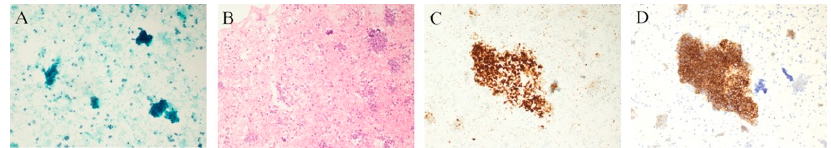
Figure 6. A case of small cell neuroendocrine carcinoma was categorized as malignant ( A , B ). Im- munohistochemistry from CBs supported the diagnosis: INSM-1 positivity ( C ) and synaptophysin positivity ( D ). Original magnification: 100× ( A ), 200× ( B – D ). Table 5. Contribution of ICC for Cytological Diagnosis was analyzed at four different levels: CB cellularity, CB method, MSRSGC categories and accuracy, which were compared with the CBs’ contributory role in final cytological diagnosis. ICC Contribution for dg n ( % ) Group for Analyses n p -Value No ICC